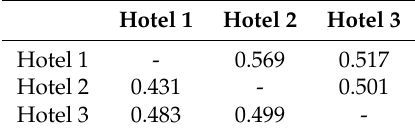
Table 9. Pairwise winning indices according to SMAA-O.